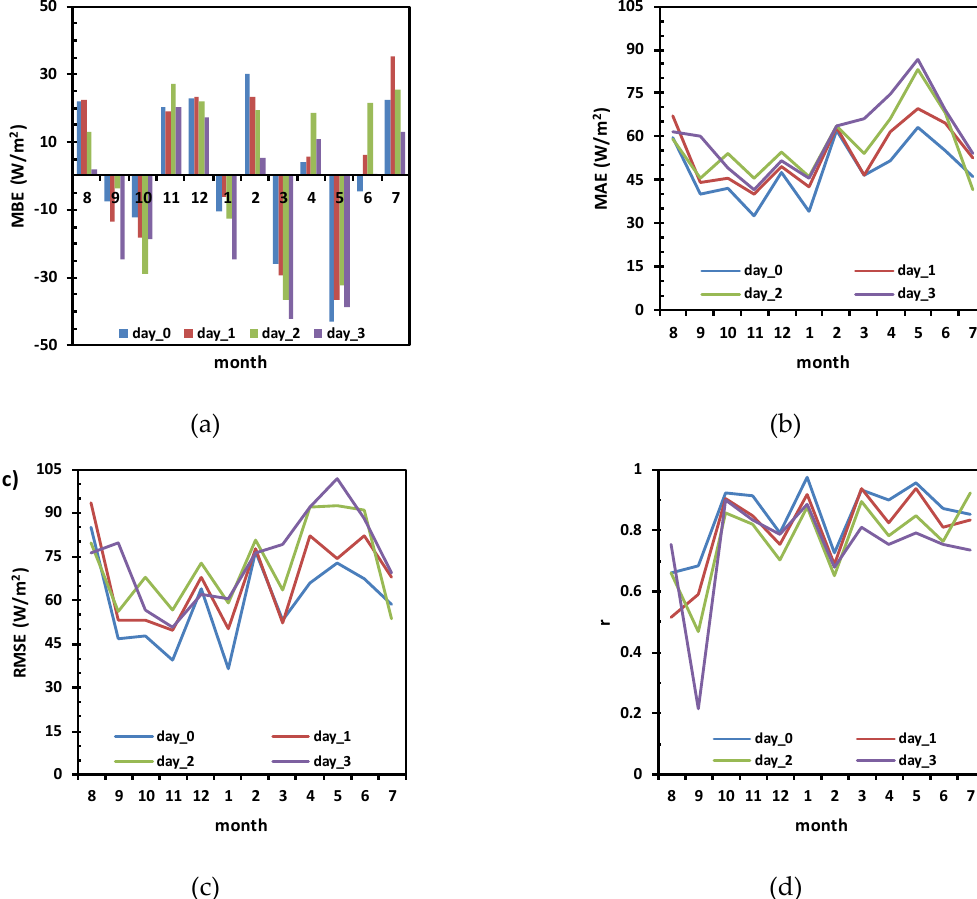
Figure 7. Statistical indicators obtained from the comparison between measurements and predictions of daily mean DNI values. ( a ) MBE; ( b ) MAE; ( c ) RMSE; ( d ) correlation coefficient. Overall, MBE, MAE, and RMSE present better results for the first day of the forecast (day_0). The highest values of statistical errors correspond to the forecasts obtained for